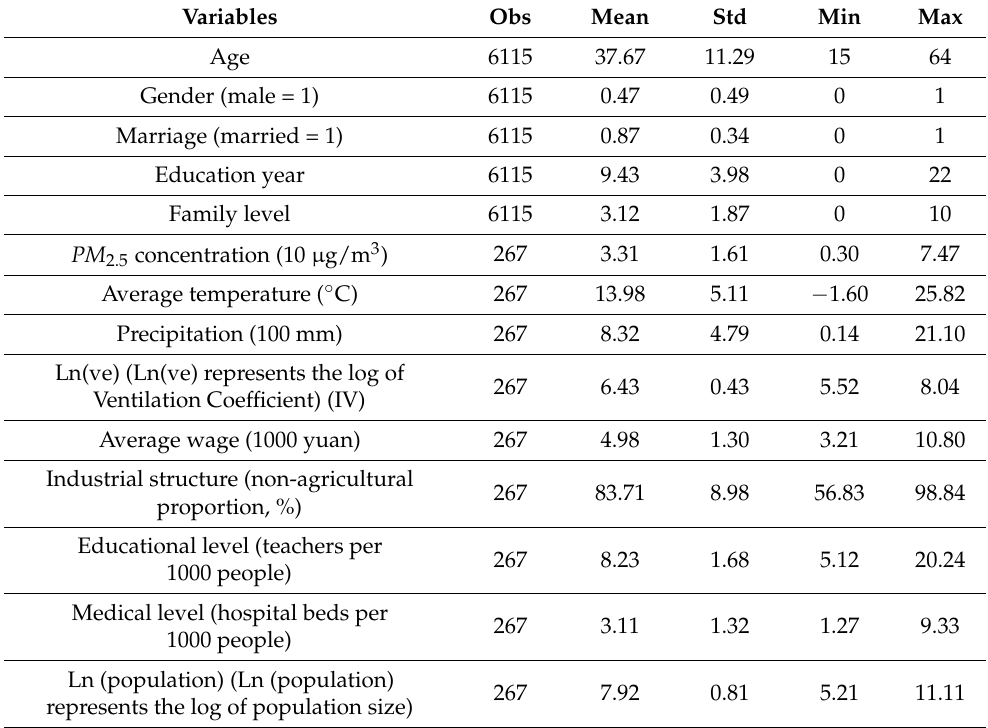
Table 1. Descriptive statistics of